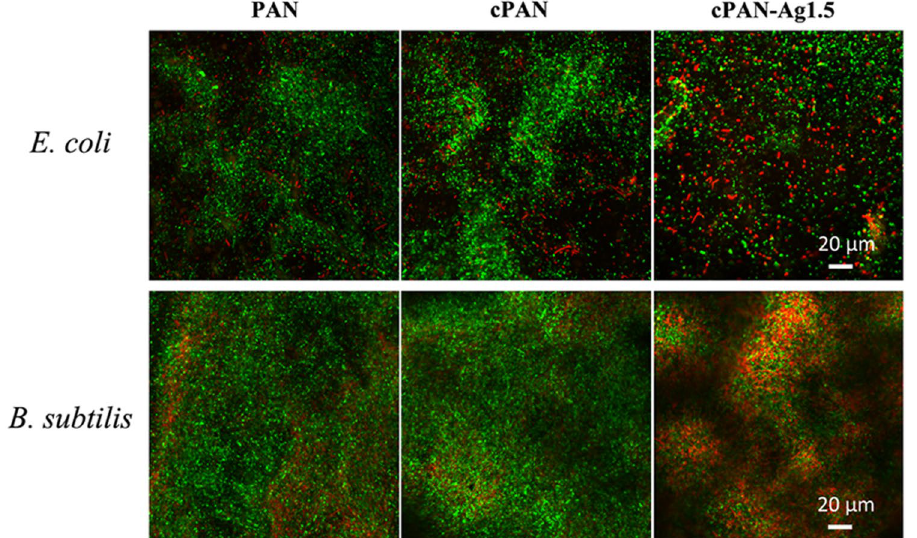
Figure 6. CLSM images of different nanofibrous membranes after filtration the bacteria suspension (green dots and red dots stands for live cells and dead cells